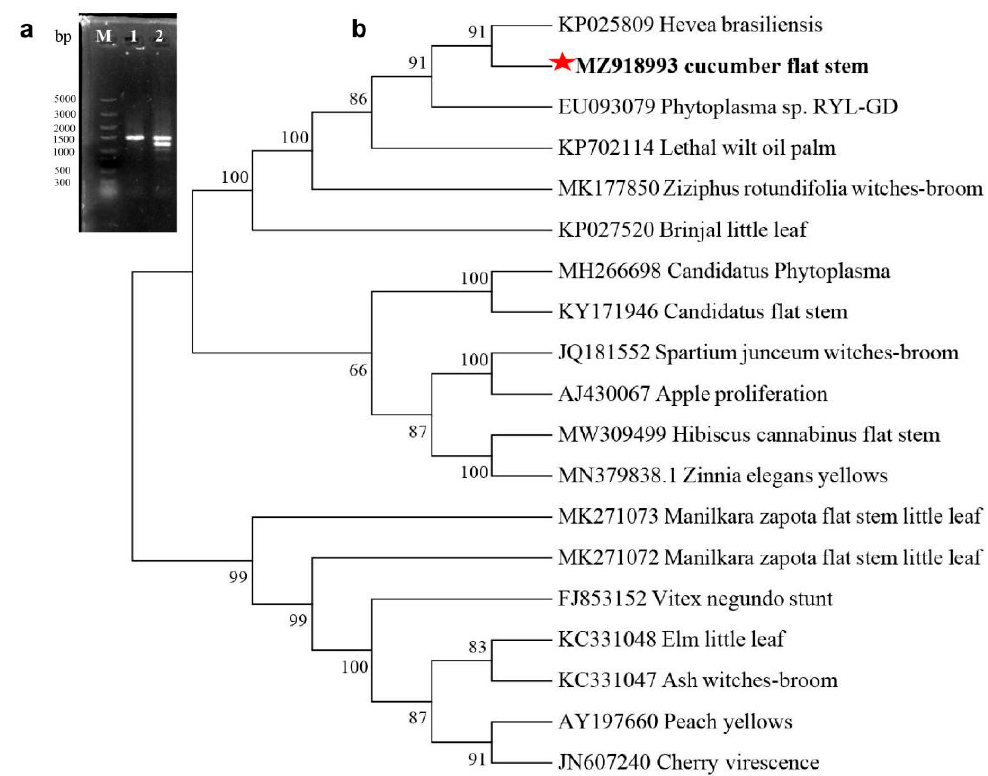
6 of 17 Figure 2. Microscopic images of stem sections in the diseased and healthy plants. Light microscopy